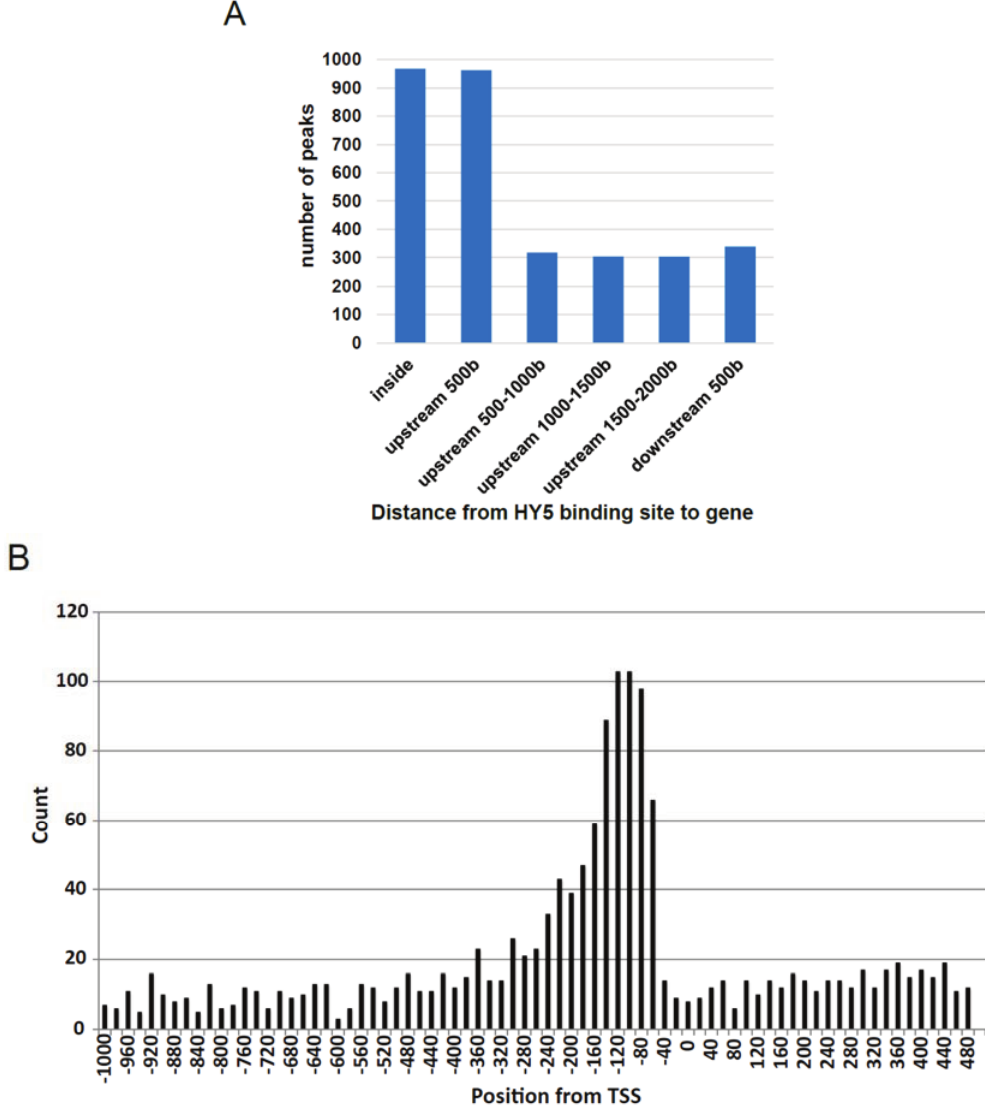
Figure 2. Peak positions derived from HY5 gDB-seq. ( A ) Positions of detected peaks around the HY5-binding genes. ( B ) Distribution of gDB-seq peak positions from transcription start sites